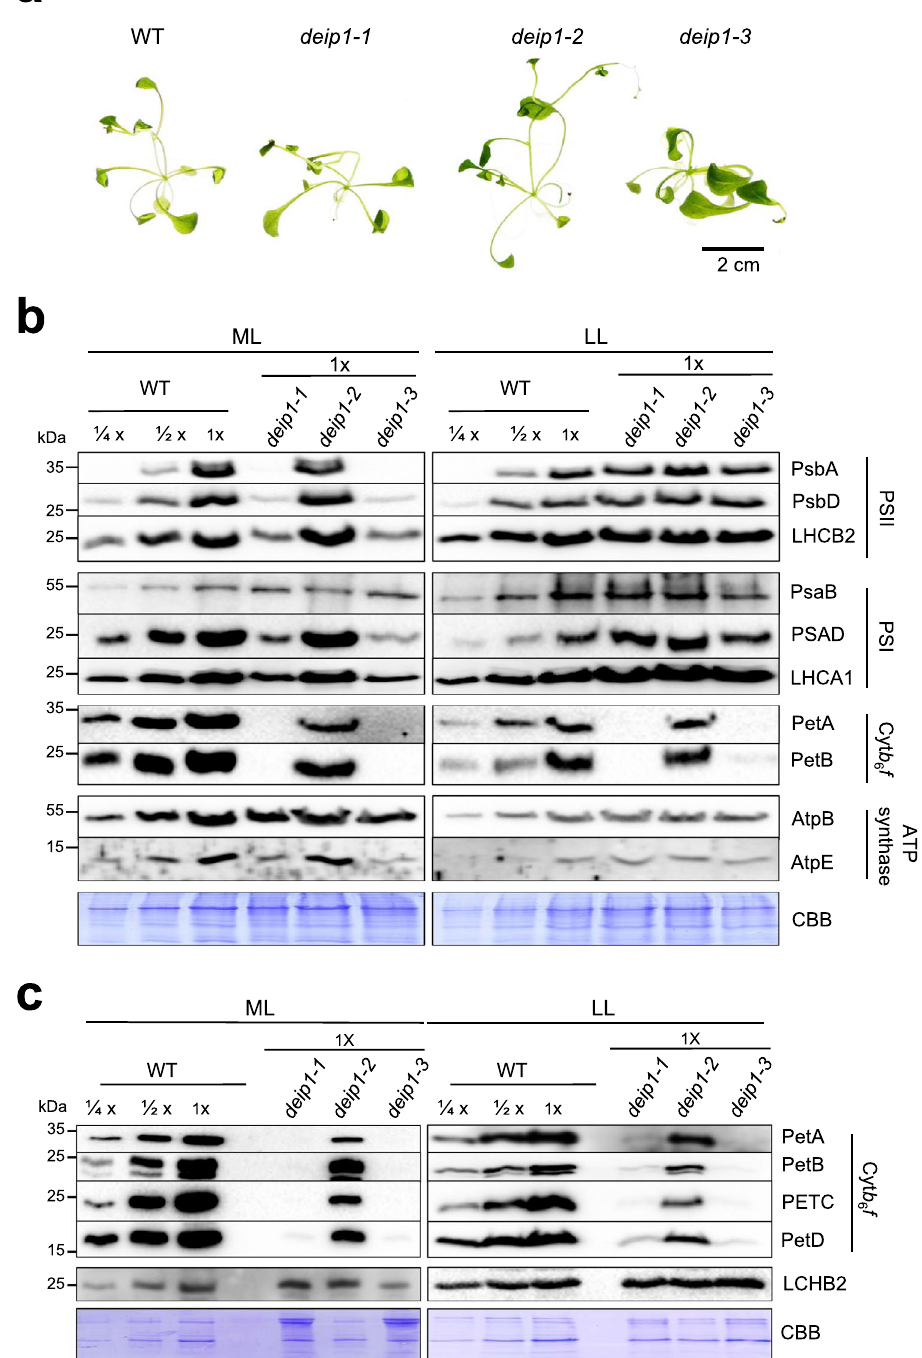
Fig. 4 Light-dependent accumulation of thylakoid proteins in deip1 mutants. a Phenotypes of 5-week-old plants grown in vitro under extreme low-light conditions (5 µ mol m − 2 s − 1 ). b Accumulation of diagnostic protein subunits of the major thylakoidal protein complexes in the wild type (WT), and the deip1-1 , deip1-2, and deip1-3 mutants grown under moderate light (ML; 95 μ mol m − 2 s − 1 ) or extreme low light (LL; 5 μ mol m − 2 s − 1 ). Samples of 20 µ g total protein were loaded for deip1-1 , deip1 - 2, and deip1-3 (1×), and blots were probed with antibodies against proteins of the PSII complex (PsbA, PsbD, and LHCB2), the PSI complex (PsaB, PSAD and LCHA2), the Cyt b 6 f complex (PetA, PetB) and the chloroplast ATP synthase (AtpB and AtpE). As a control for equal loading, the Coomassie-stained PAA gel (CBB) is shown below each series of immunoblots. n = 3 independent biological replicates. c Protein accumulation in thylakoids puri fi ed from the wild type (WT) and the deip1 mutants grown under moderate light (ML) or extreme low light (LL). Thylakoid protein samples equivalent to 1 μ g of chlorophyll were resolved in 12.5% PAA gels and blotted. Immune detection was conducted with antibodies against the Cyt b 6 f subunits PetA, PetB, PETC, and PetD. The light-harvesting complex protein LHCB2 served as a marker for equal chlorophyll-based loading, and the Coomassie-stained PAA gel (CBB) is shown below each series of immunoblots. Note that, due to their low chlorophyll content, the amount of loaded protein is substantially higher in the deip1-1 and deip1-3 mutants grown under ML. n = 3 independent biological replicates.